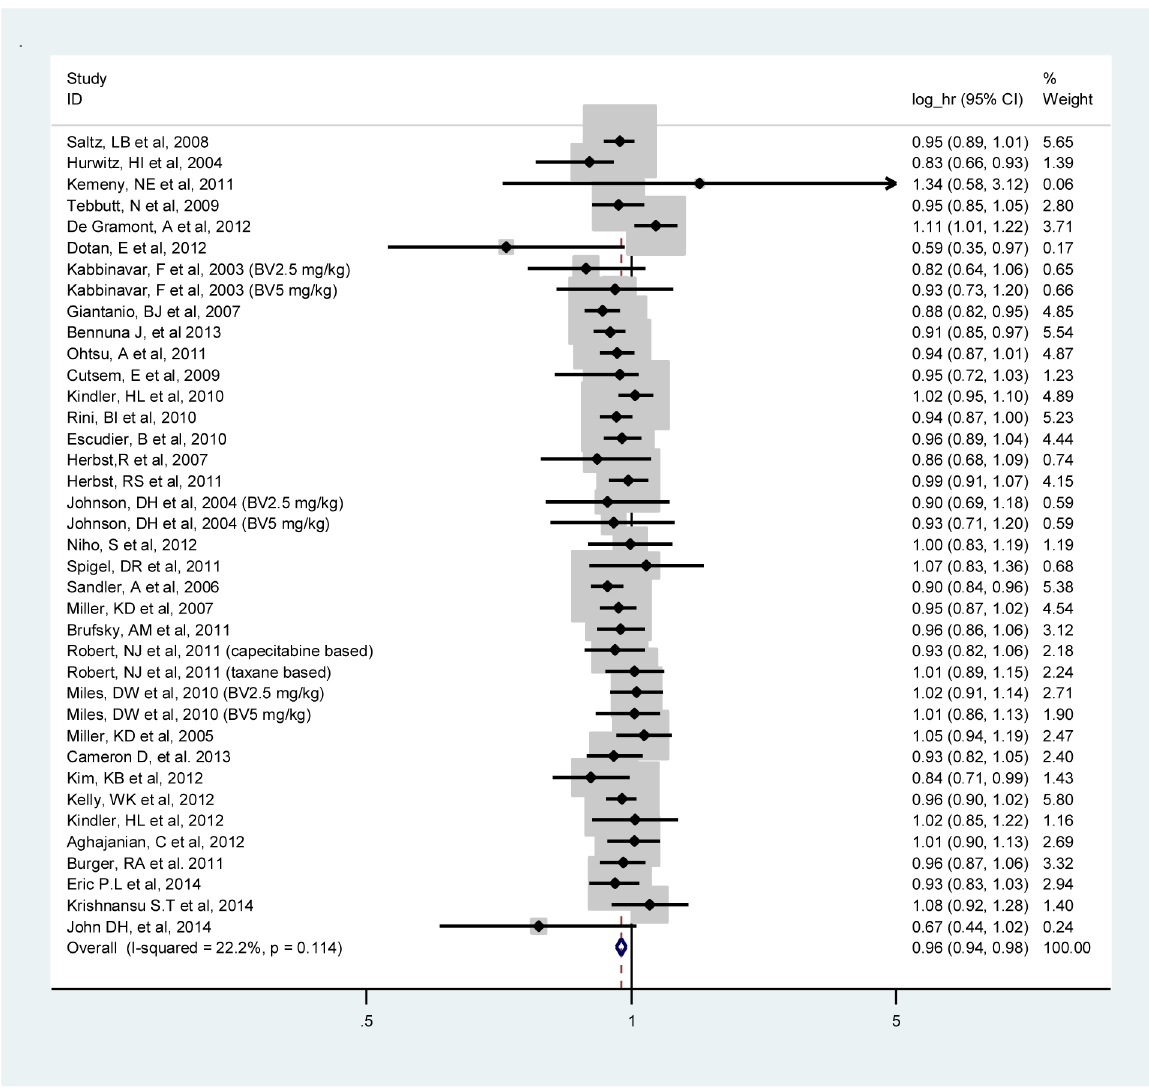
Fig 3. Meta-analysis of the logs hazard ratios of overall survival comparing bevacizumab and standard therapy in all trials combined.